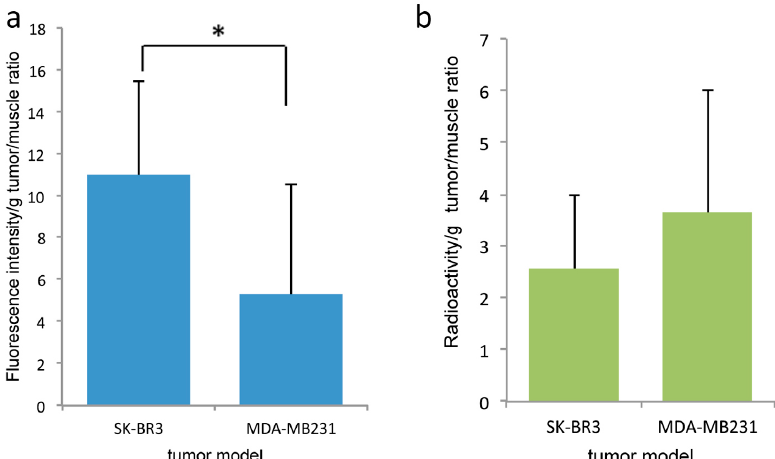
Figure 8. Comparison of fluorescence intensity and radioactivity in xenografted tumors on direct- 99m Tc-chelated dual-imaging probe studies. There is a significant difference in fluorescence intensity between SK-BR3 tumors and MDA-MB231 tumors (SK-BR3, n = 8, MDA-MB231, n = 7) ( a ). However, there is no significant difference in radioactivity between SK-BR3 tumors and MDA-MB231 tumors ( b ) (* p < 0.05).